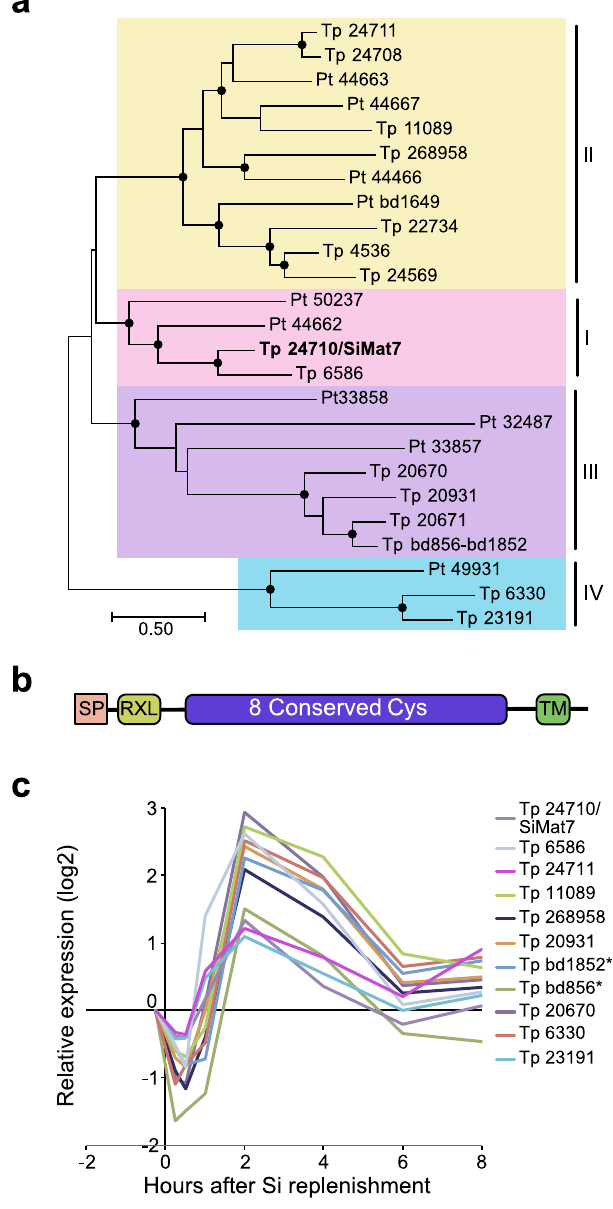
Figure 3. A new family of conserved transmembrane proteins possibly involved in frustule biosynthesis. ( a ) Phylogenetic tree of the SiMat7-like protein family, based on a protein alignment of all SiMat7-like proteins in T. pseudonana (Tp) and P. tricornutum (Pt). Black circles indicate nodes supported by maximum likelihood and neighbour-joining bootstrap values (1000 × sampling) > 80%. The numbers indicate JGI Thaps3 gene IDs. SiMat7 is indicated in bold letters. The SML subfamilies are indicated by colours. ( b ) Predicted domain structure of the SiMat7-like proteins. SP, signal peptide; RXL, protease cleavage motif, TM, transmembrane domain. ( c ) Expression profile of selected SiMat7-like genes during Si shift-up experiment. * Tp bd856 and Tp bd1852 constitute the 5 ′ and 3 ′ parts of the same gene, respectively, and not two genes as annotated in the genome